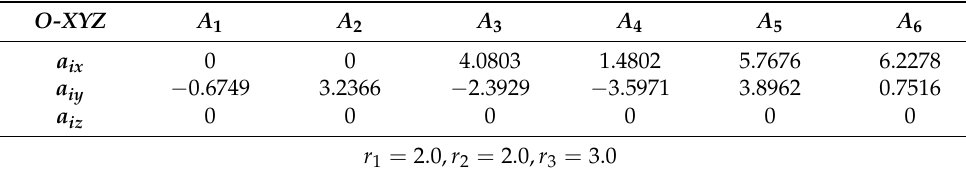
Table 3. Link parameters and inputs for example 2.